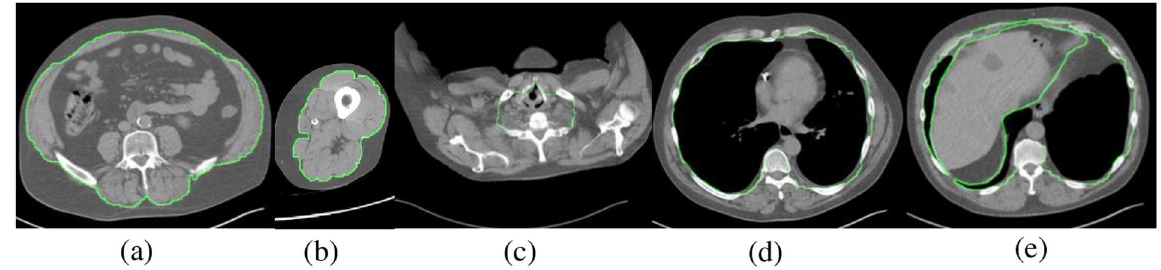
Fig 1. Definition of SAT-VAT interface illustrated through boundary contour drawn on slices: (a) at L4-L5 level in lower abdominal region, (b) through mid-thigh level, (c) in upper thorax, (d) in mid thorax, and (e) in lower thorax at level of